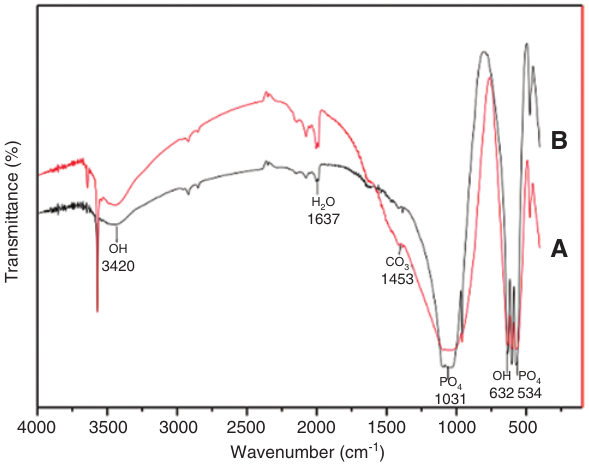
Figure 7: XPS survey spectrum of phase-pure hydroxyapatite nanorods of sample 1, synthesized using calcium nitrate and diammonium hydrogen phosphate precursors via co-precipitation